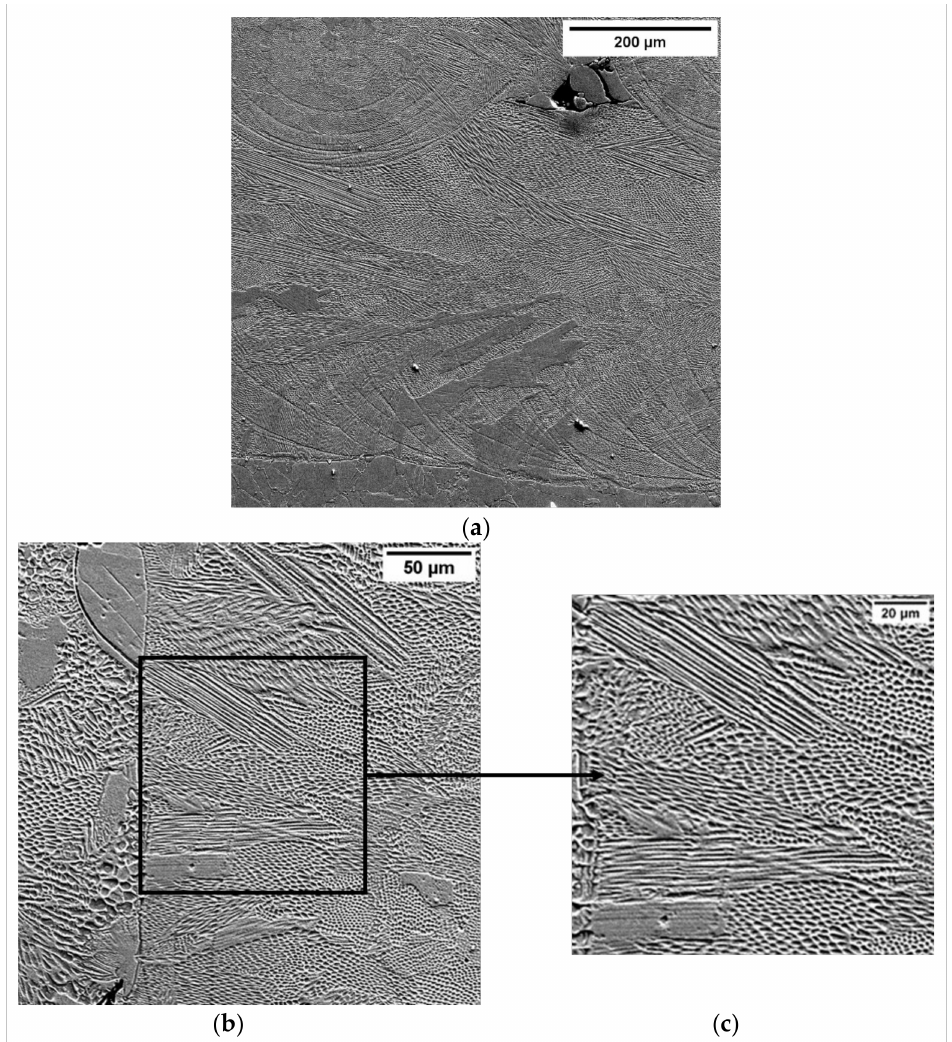
Figure 5. ( a – c ) SEM metallography showing laser track cross-sectional microstructures of deposited AISI 316 steel